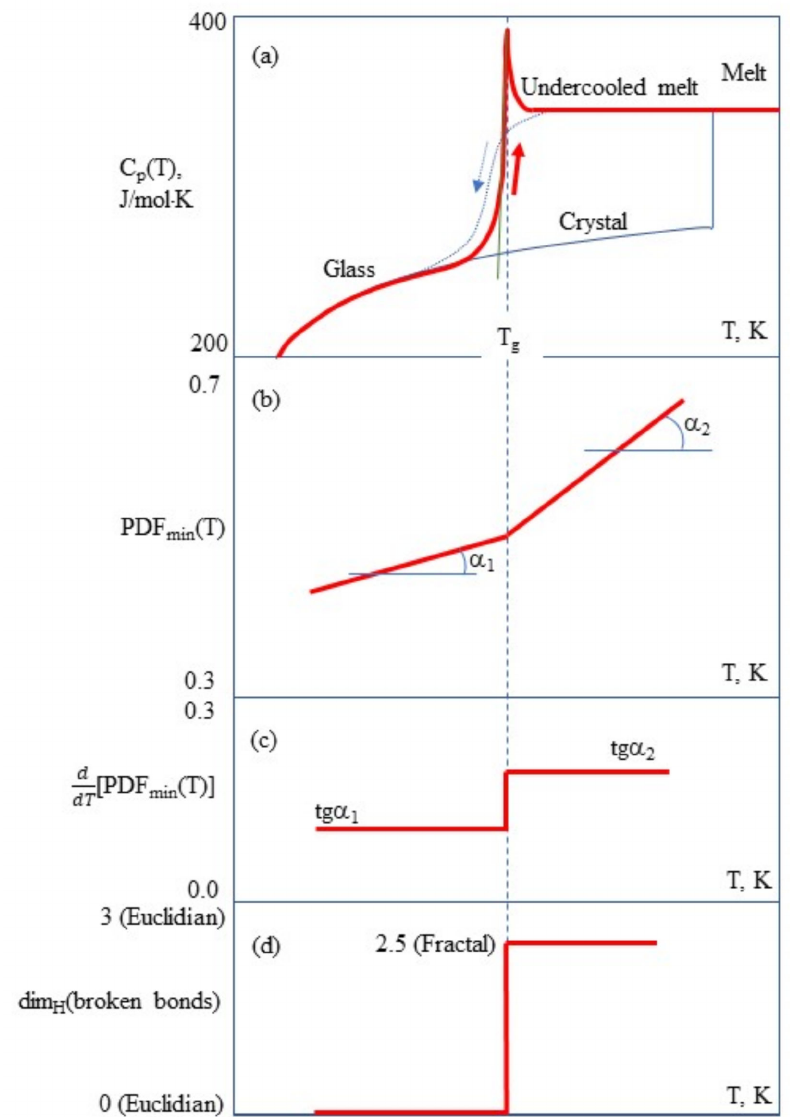
Figure 3. The main characteristics of glass–liquid transition that demonstrate the thermodynamic origin and structural changes behind transformation. ( a ) The temperature (T) dependences of the isobaric heat capacity (C p ) by differential scanning calorimetry (DSC) during the heating of a glass at a typical rate of 10 K/min. The glass − liquid transition during upscan is always featured by a C p jump, whereas the vitrification (liquid − glass transition) on cooling during downscan is reflected by a gradual C p drop [30]. ( b ) The temperature dependence of the first sharp diffraction minimum (FSDM) value of pair-distribution function (PDF min ) on the scattering of incident neutron or X-rays indicating that at the T g there is a substantial change of slope due to structural changes at the glass transition [31]. ( c ) The temperature dependence of the first temperature differential of FSDM value d(PDF min )/dT indicating that at the T g , there is a stepwise change of slope due to structural changes at the glass transition [31]. ( d ) The temperature dependence of the Hausdorff–Besicovitch dimension D = dim H (broken bonds) of the set of broken chemical bonds at the glass transition changes suddenly as change the material properties. The set of broken bonds termed configurons has D = 0 below the T g, and D = 2.55 ± 0.05 above it